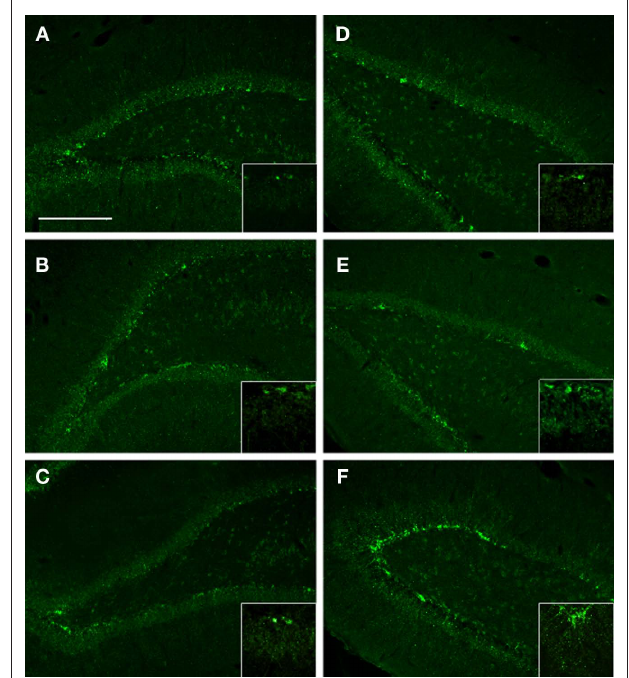
Figure 5 | gFAP immunoreactivity in selected brain regions of animals in the various experimental groups. Frozen coronal sections containing the DHC and the VHC were cut and processed for immunohistochemistry using a GFAP antibody. DHC of NH-S (A) , NH-I (B) , and EEN-I (C) rats; VHC of NH-S (D) , NH-I (e) , and EEN-I (F) rats. Inlays magnify GFAP morphology. Scale bar (A–F) = 100 μm.